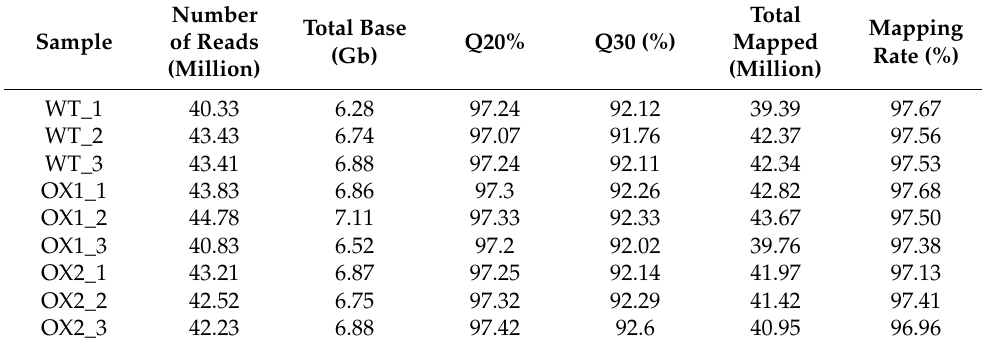
Table 1. The RNA-Seq. Data sets’ Summary of Transgenic plant ( TEA031065 ) gene in A. thaliana .